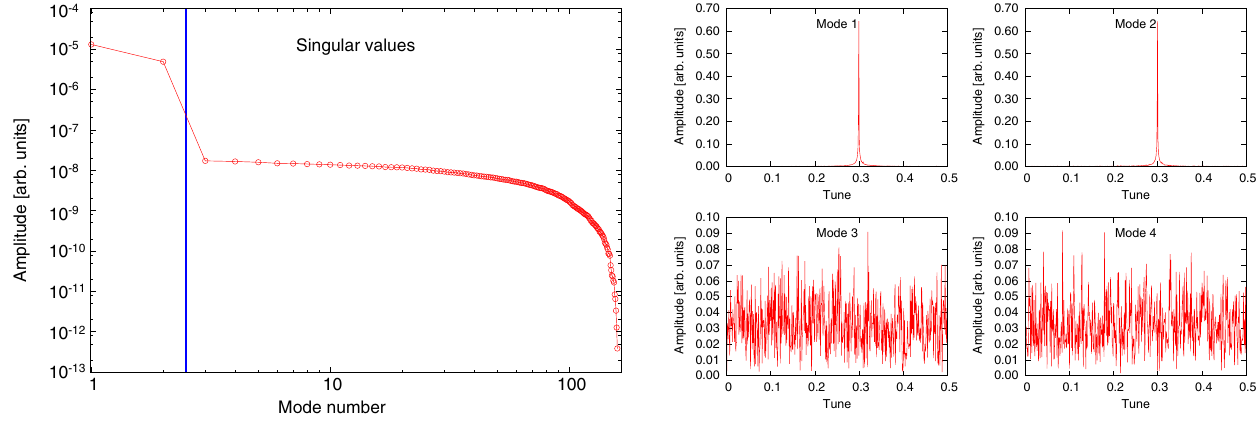
FIG. 1. Left: Typical distribution of singular values for the simulated TBT BPM data. The cutoff mode number is chosen to be n c ¼ 2 . Right: Typical spectrum of temporal functions from mode 1 to 4 for the simulated turn-by-turn data. Modes 1 and 2 correspond to betatron motion, while modes 3 and 4 are